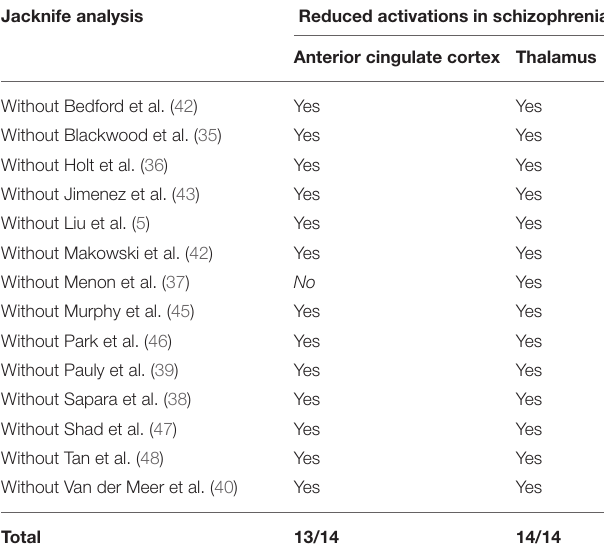
TABLE 3 | Jacknife